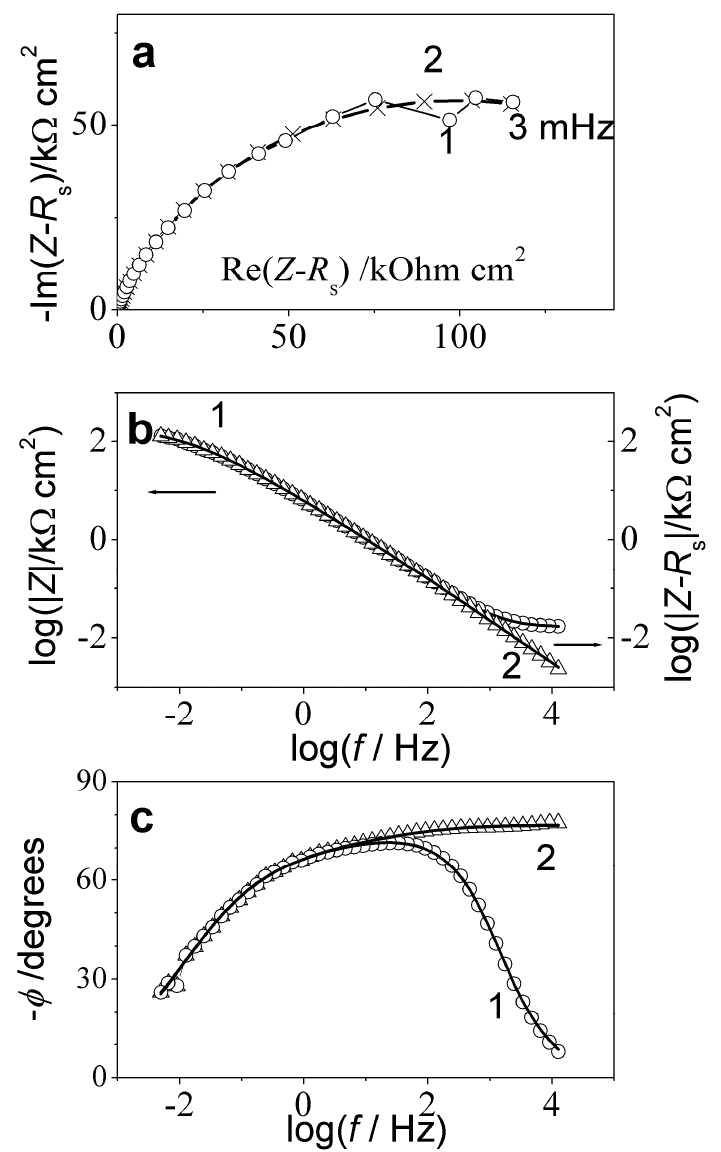
Fig. 7 Measured and calculated (according to the EC model of Fig. 9a.) impedance diagrams determined at the corrosion potential E corr = –0.086 V of the electrodeposited sample A after 18 h corrosion immersion followed the SWPC treatment: (a) in complex plane: 1-o- measured, 2-x- fitted data; (b) and (c) the corresponding Bode plots: 1, 2 – with symbols the measured, with solid lines the fitted data; 1- original data, 2 – 1 data set with subtraction of solution